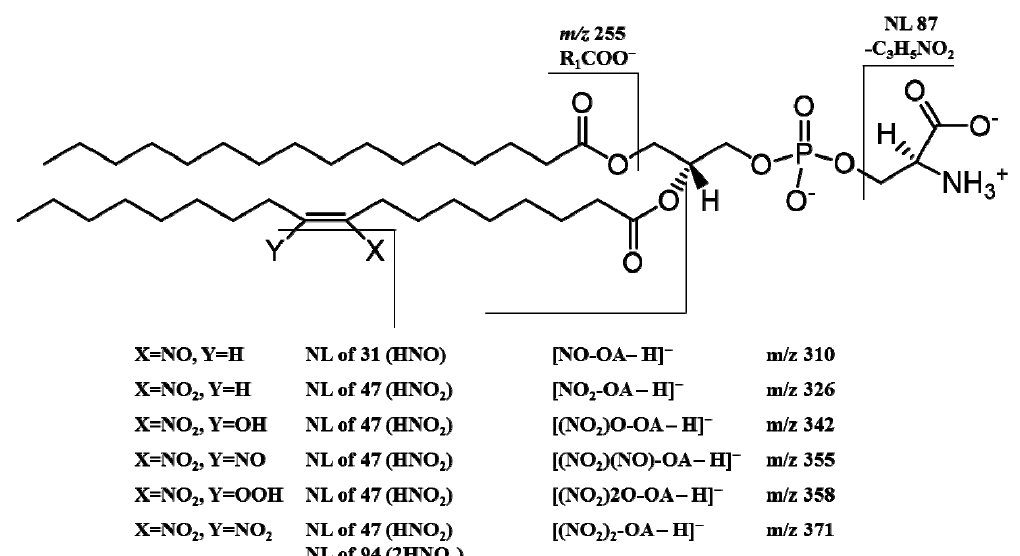
Figure 4. Schematic representation of major fragmentation pathways of nitrated POPS derivatives observed in negative-ion mode. A possible chemical structure of nitrated POPS with the nitro (NO 2 ) and nitroso (NO) groups located in C9 is represented, but other possibilities should be considered, namely the nitro (NO 2 ) and nitroso (NO) groups at C10, as reported for the nitration of oleic acid [12]. Previous results showed that nitrate POPC could have health protective effects as an antioxidant due to its capability of trapping harmful radicals [17], since it was able to scavenge the ABTS ● + , DPPH ● , and oxygen-derived radicals (ORAC assay), and protect against lipid peroxidation induced by the hydroxyl radical [17]. In this study, we have further evaluated the ability of non-modified POPS and nitrated POPS to trap radicals as H-atom donator and thus act as a scavenger of radicals, by performing experiments with DPPH ● and ABTS ● + radicals. Both assays were performed using all the nitration reaction mixture of POPS.